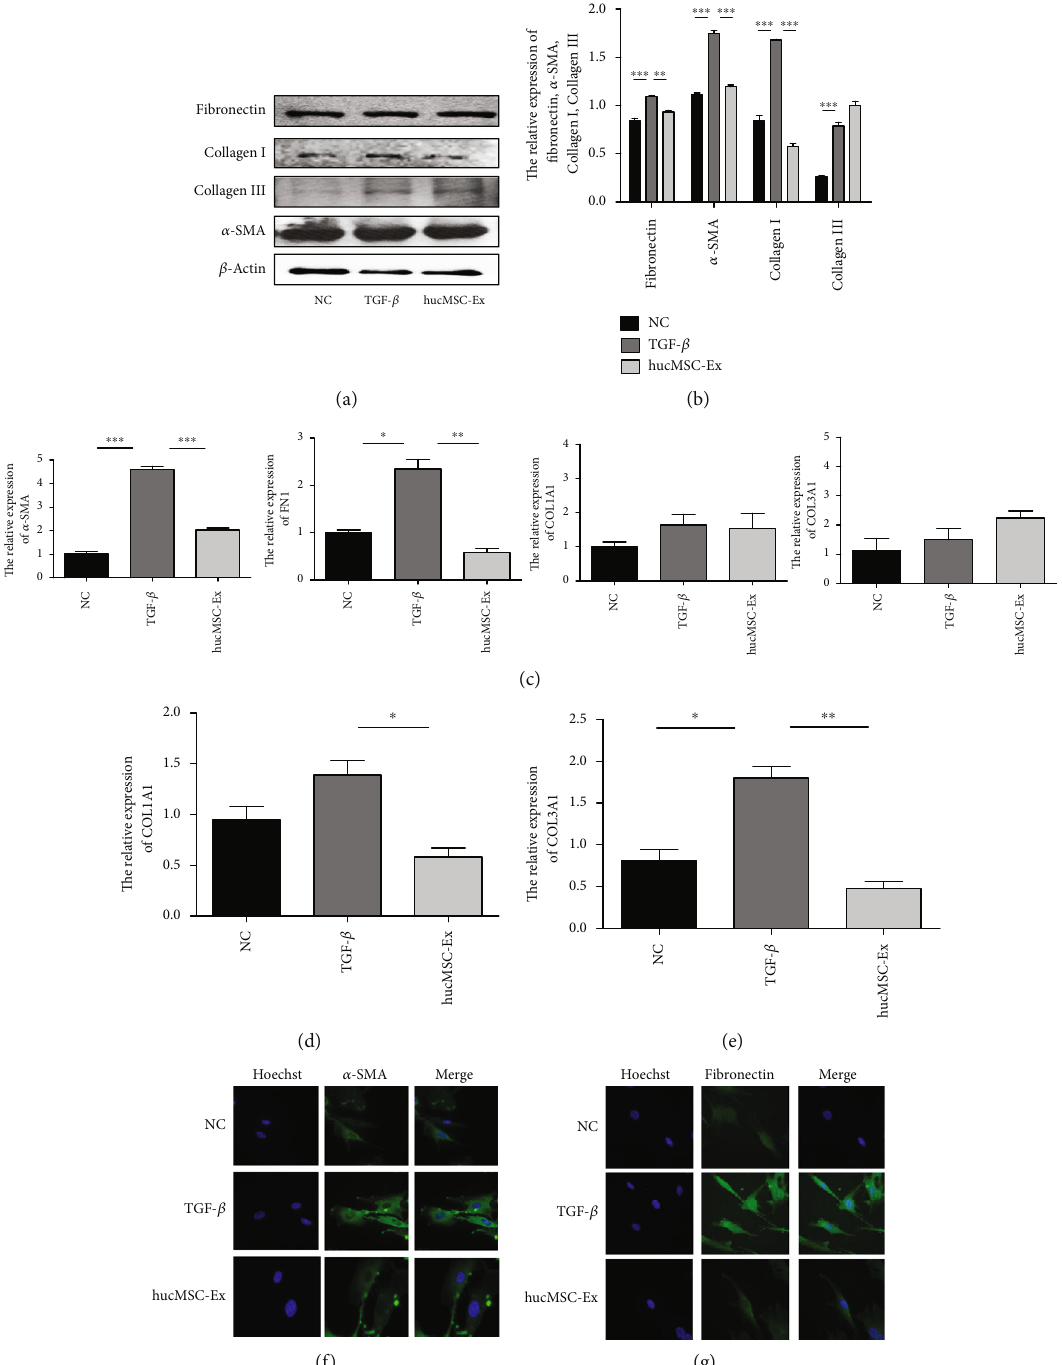
Figure 5: hucMSC-Ex inhibits the expression of α -SMA, collagen I, collagen III, and fi bronectin in colonic fi broblasts. (a) Western blot analysis of α -SMA, collagen I, collagen III, and fi bronectin expression in human intestinal fi broblasts CCD18-Co after treatment with TGF- β for 48 hours. (b) Grayscale scanning of (a), ∗∗ P < 0 : 01 and ∗∗∗ P < 0 : 001 . (c) QPCR analysis of α -SMA, COL1A1, COL3A1, and FN1 expression in human intestinal fi broblasts CCD-18Co after treatment with TGF- β for 48 hours, ∗ P < 0 : 05 , ∗∗ P < 0 : 01 , and ∗∗∗ P < 0 : 001 . (d) QRT-PCR analysis of COL1A1 expression in human intestinal fi broblasts CCD-18Co after treatment with TGF- β for 24 hours, ∗ P < 0 : 05 . (e) QRT-PCR analysis of COL1A1 expression in human intestinal fi broblasts CCD-18Co after treatment with TGF- β for 72 hours, ∗ P < 0 : 05 and ∗∗ P < 0 : 01 ; (f) IF analysis of α -SMA expression in human intestinal fi broblasts CCD-18Co after treatment with TGF- β for 48 hours (400x). (g) IF analysis of fi bronectin expression in human intestinal fi broblasts CCD-18Co after treatment with TGF- β for 48 hours